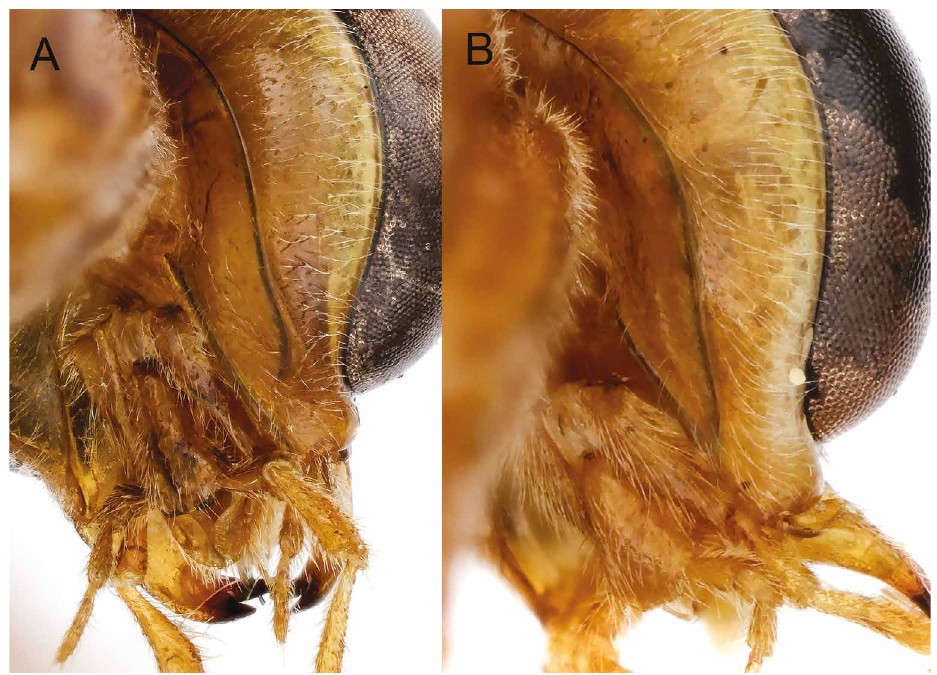
Fig. 6. Occipital carina, postero-ventral view. A . Enicospilus adustus (Haller, 1885), ♀. B . E. ryrholmi sp. nov., paratype, ♀ (NHRS-HEVA000008149).